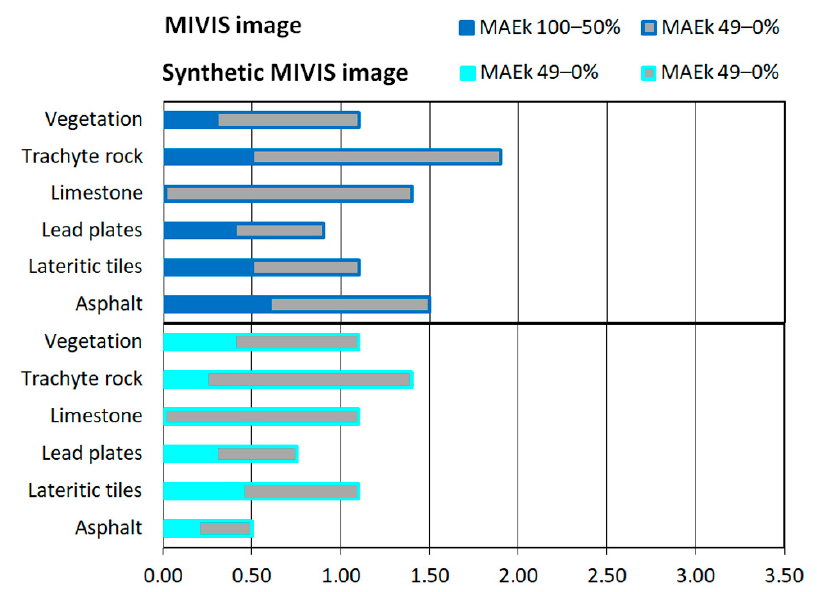
Figure 13. The error in spatial validation calculated from true and synthetic images exploiting FAMs (i.e., the fifth